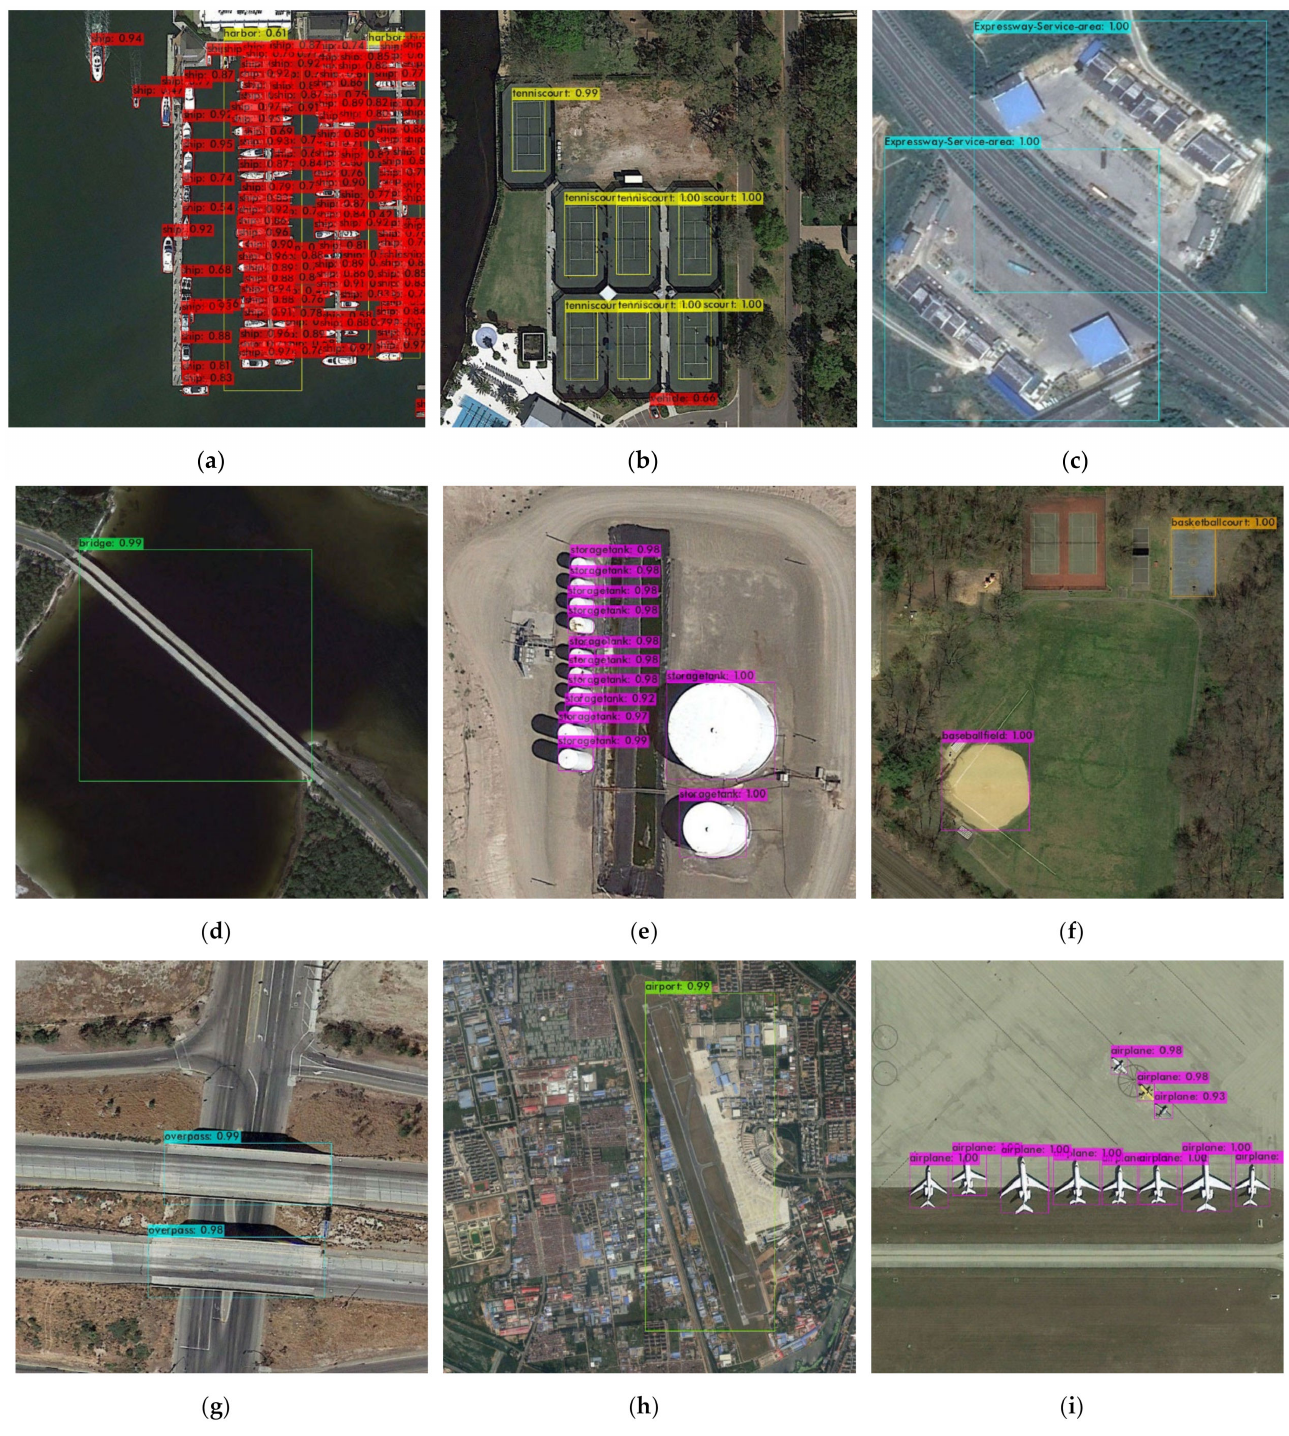
Figure 8. Detection results of RepDarkNet in the Dior dataset ( a – i